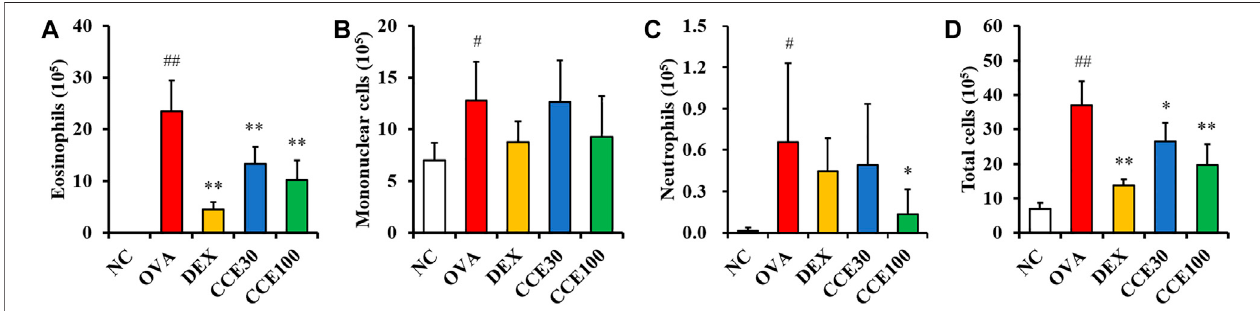
FIGURE3 | CCE decreased in fl ammatory cell recruitment inBALF from OVA-exposed mice. (A) Eosinophils, (B) mononuclear cells, (C) neutrophils, (D) total cells. NC,nonasthmaandPBStreatment;OVA,asthmaandPBStreatment;DEX,asthmaanddexamethasonetreatment;CCE30andCCE100,asthmaandCCEtreatment